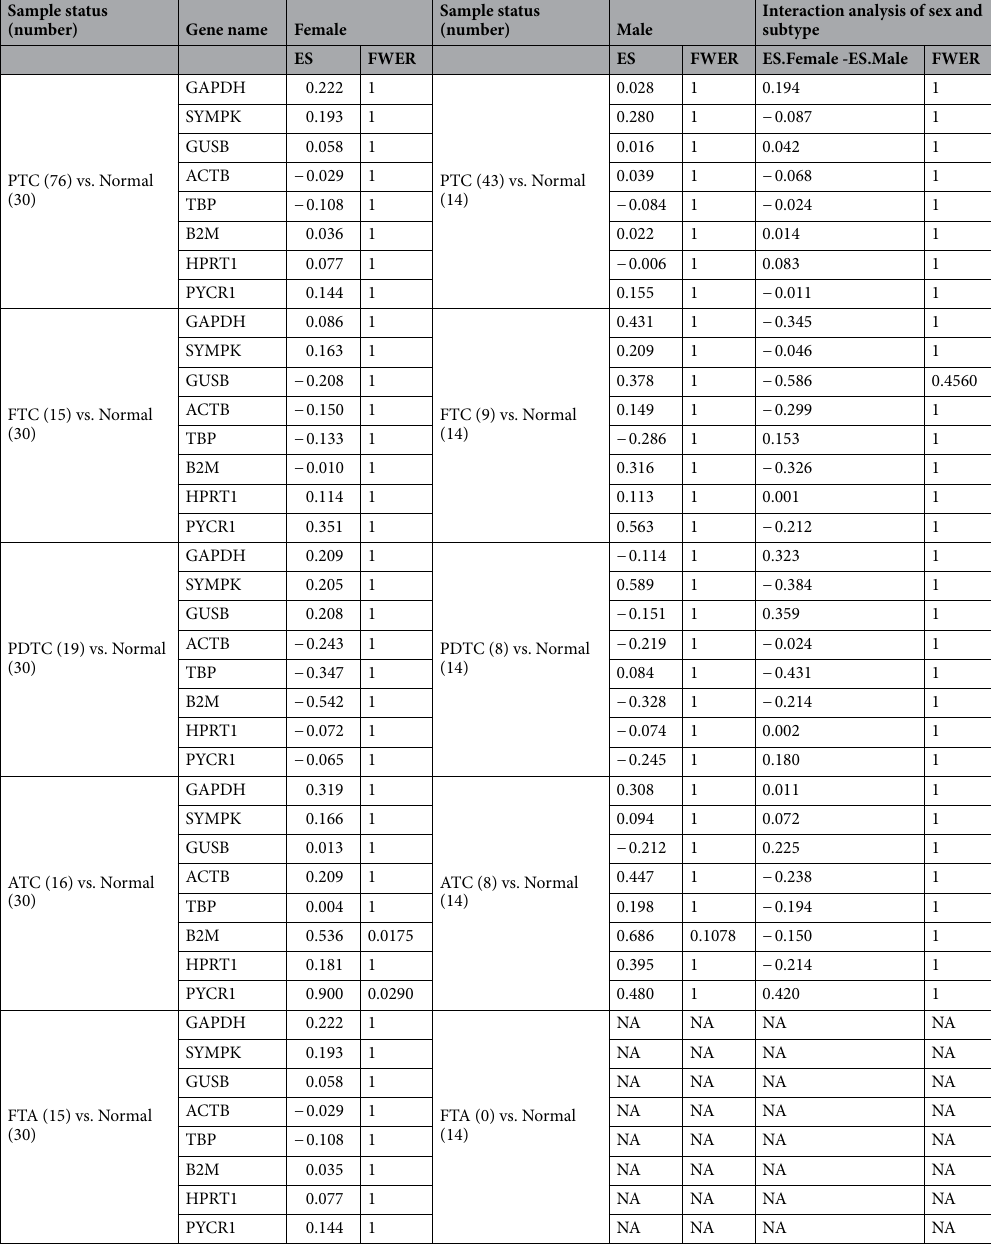
Table 3. Intra-sex analyses, as well as sex-subtype interaction. Using three scenarios, the expression levels of eight common reference genes are compared between normal tissues and each subtype of thyroid cancer. In the first scenario, a linear model was used to calculate differential expression in females: expression ~ tumor, where tumor was a binary variable (tumor vs. normal). In the second scenario, male differential expression was calculated using the same linear model as in the first. In the third scenario, the differential expression of differences was calculated using a complex linear model: expression ~ group, where group was a single factor made up of sex and subtypes. As a result, the binary variable was female vs. male, and the contrast was (female. tumor-female.normal)—(male.tumor-male.normal). For intra-sex and interaction analyses, ES and FWER are presented separately. The interaction could not be calculated because there was no male with FTA subtype. ES effect size, FWER family-wise error